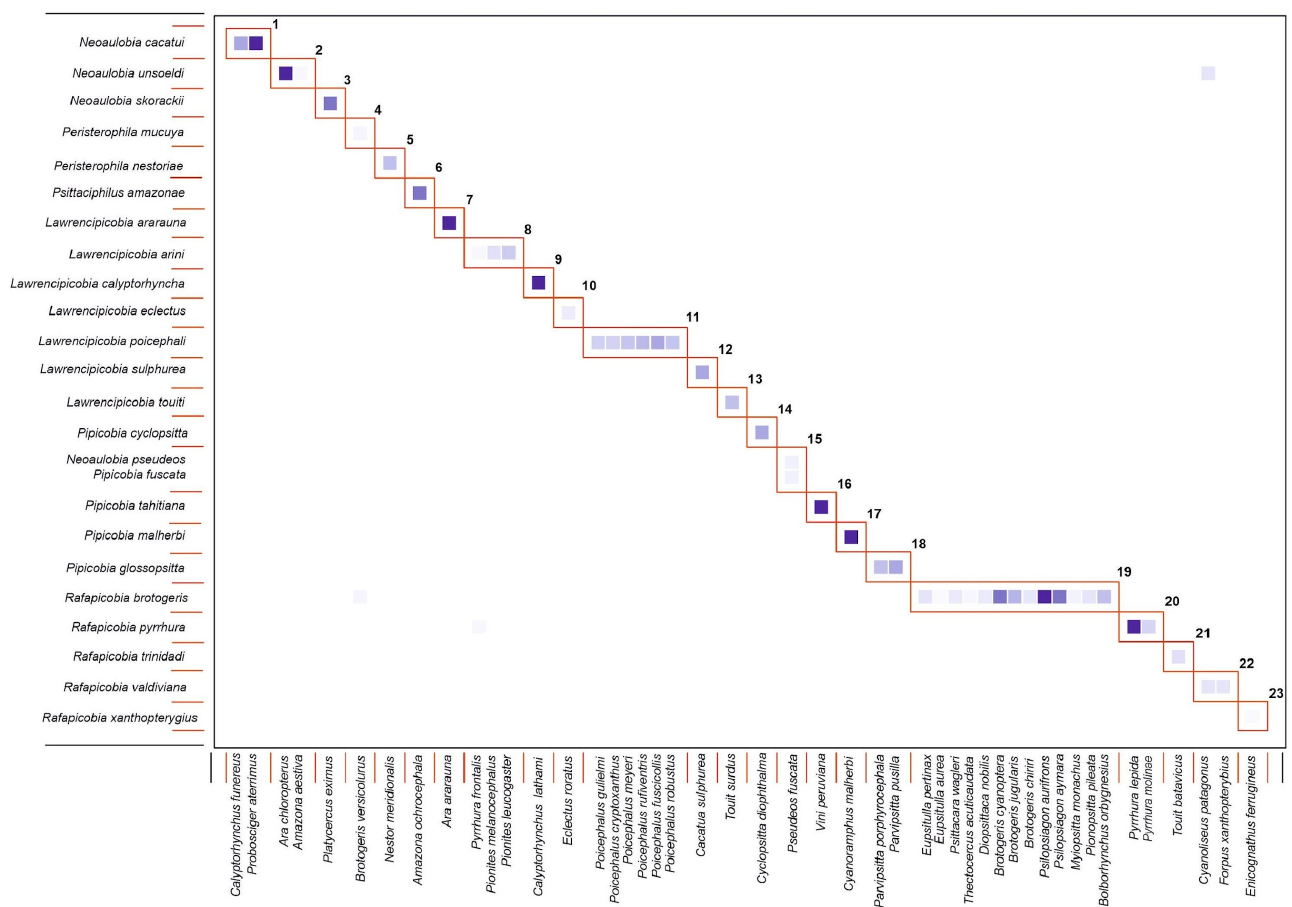
Figure 2. Modules of the quill mites–parrot communities. Modules 1–23, generated for quill mites species and parrots. The intensity of the colors of the squares indicates the strength of the interaction between particular parasite species (vertical axis) and their host species (horizontal axis).